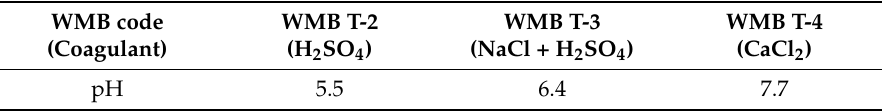
Table 5. pH value of WMBs according to the coagulant